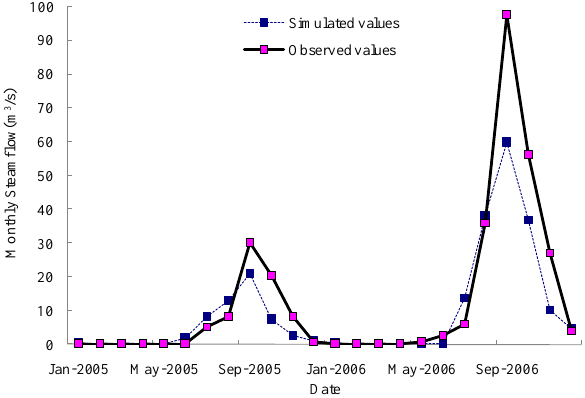
Fig. 7. Simulated monthly water area and water volume in the Zhalong Wetland, Northeast China, during 1985–2006.